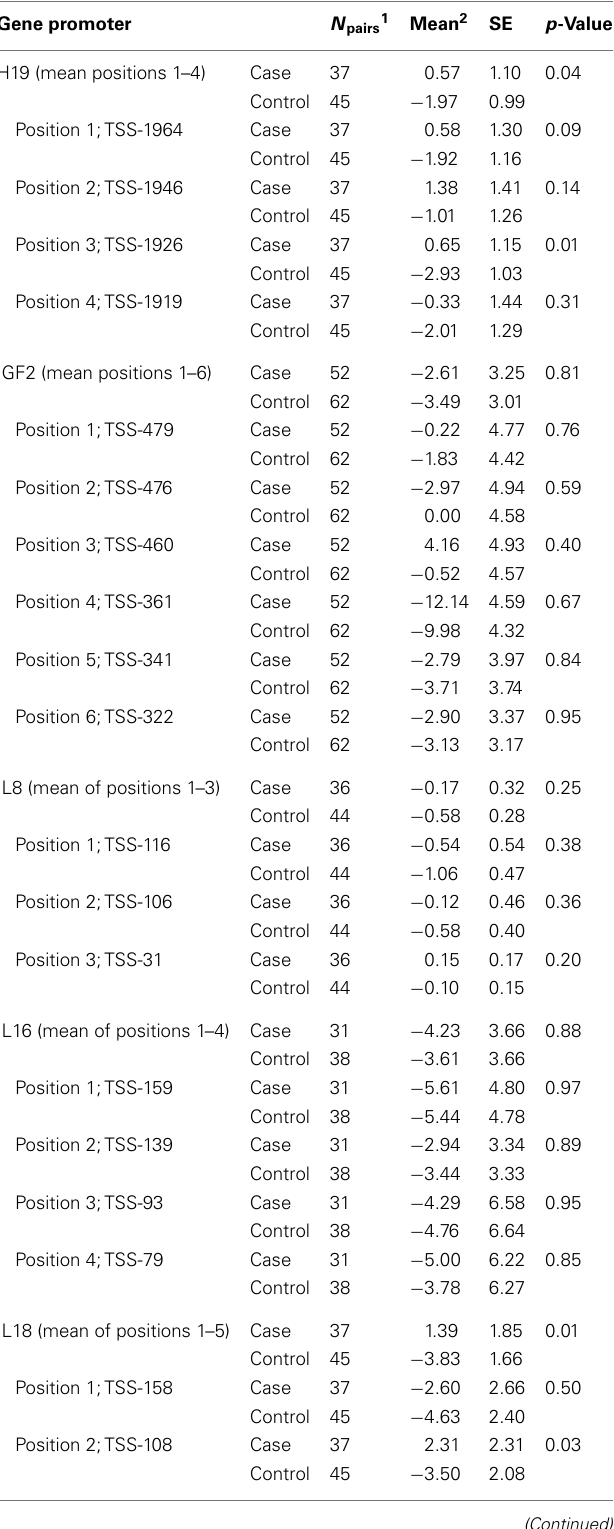
Table 2 | MultivariateANOVA comparing adjusted * mean of pre-post methylation difference between cases and